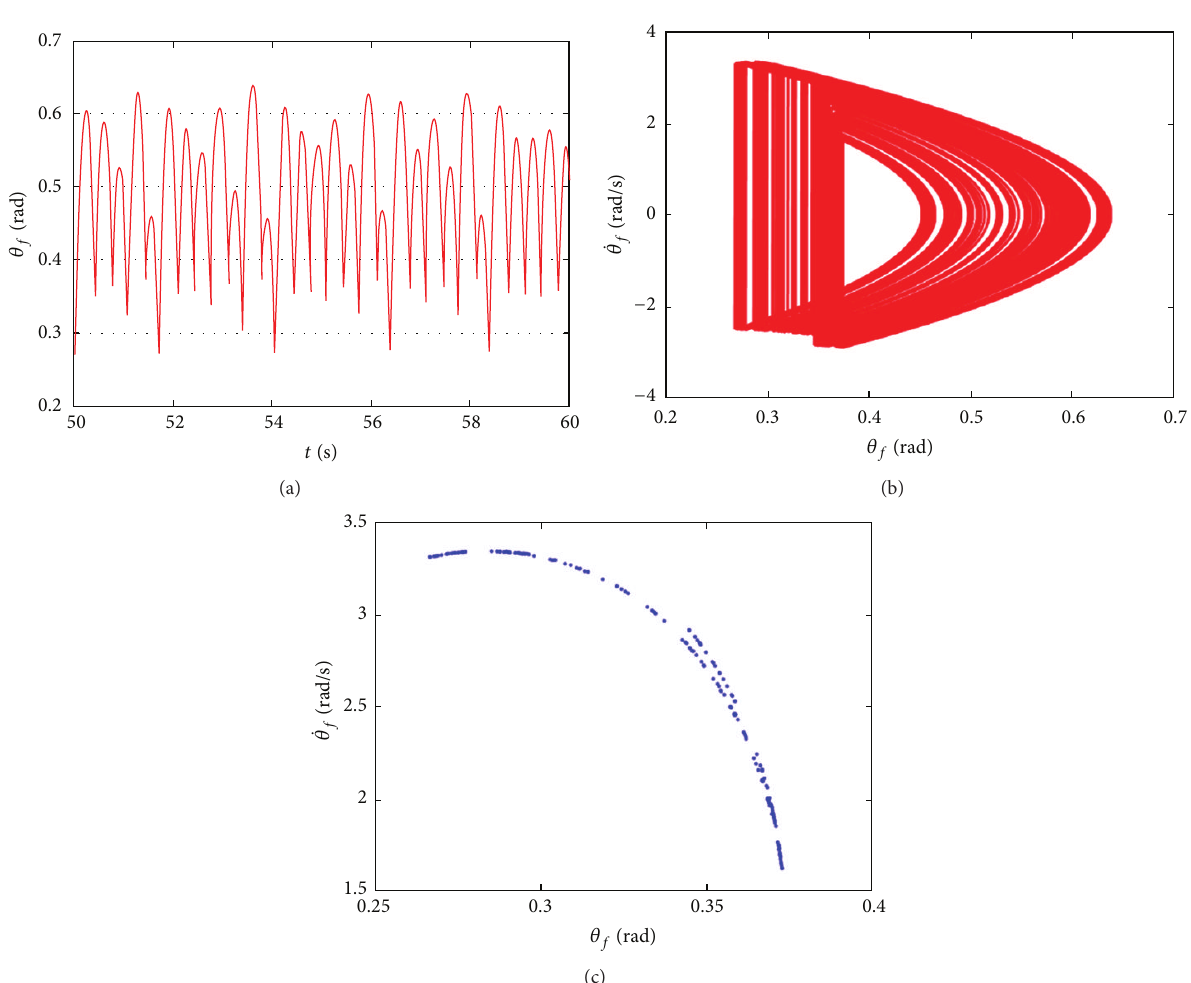
Figure 9: Chaos motion when 𝜔 = 18.84 rad/s: (a) time history; (b) phase diagram; and (c) Poincar´e